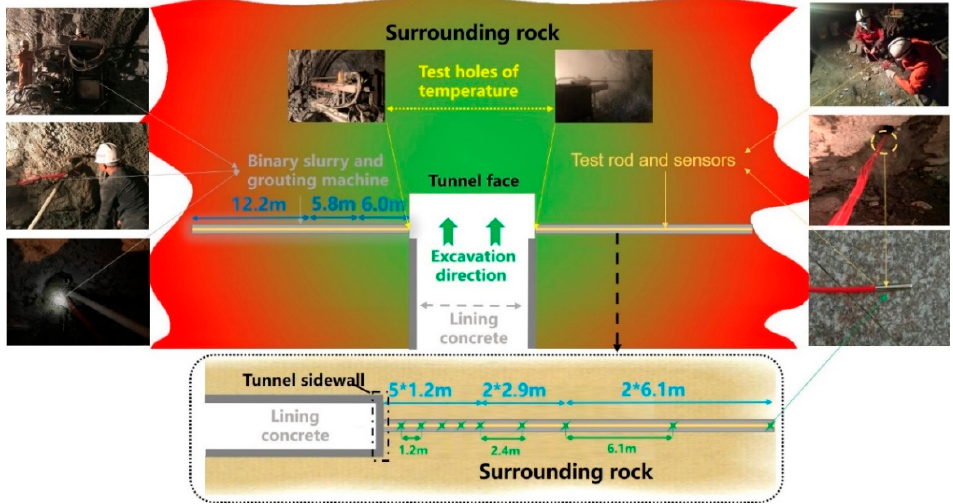
Figure 5. Field test arrangement for surrounding rock temperature.